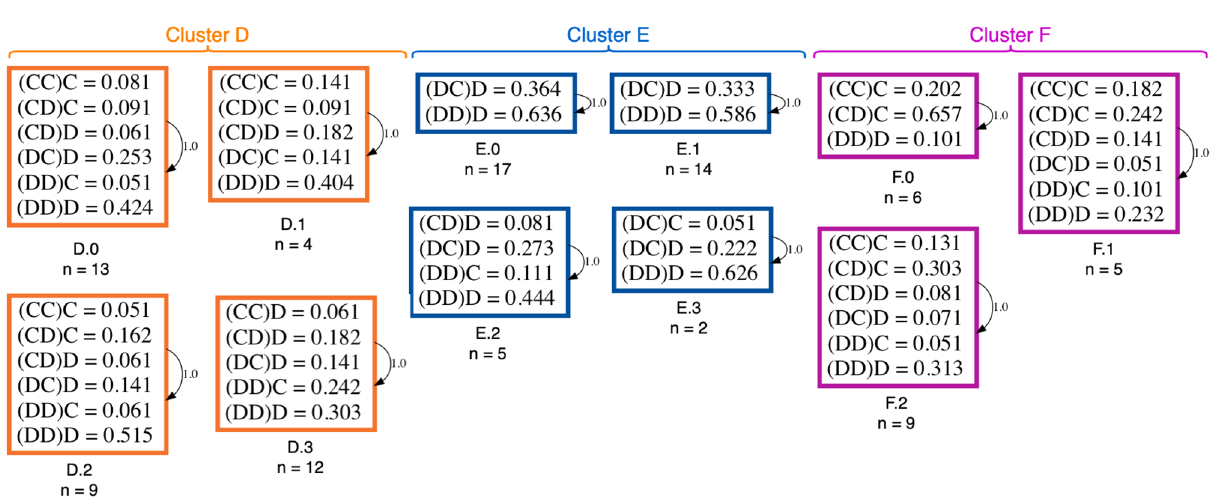
Figure 7. Hidden Markov Models for the Shuffled Partners treatment. Here, the eleven sub-clusters found in SP have a HMM that describes each sub-cluster’s strategy. Symbols with a probability less than 0.05 were not shown, as well as the transition between states less or equal to